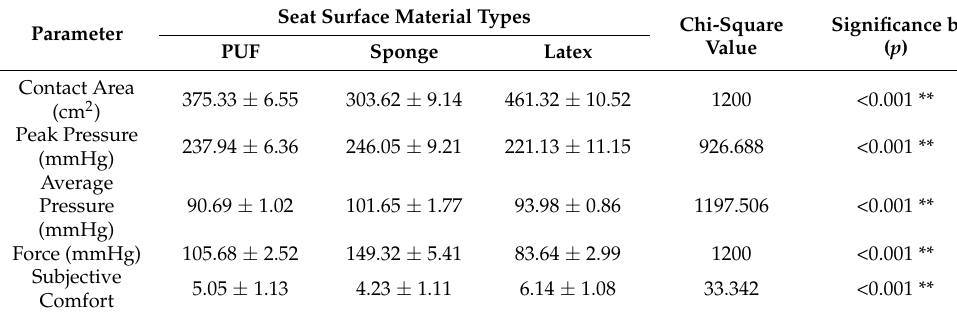
Table 3. The effect of seat surface material on body parameters.